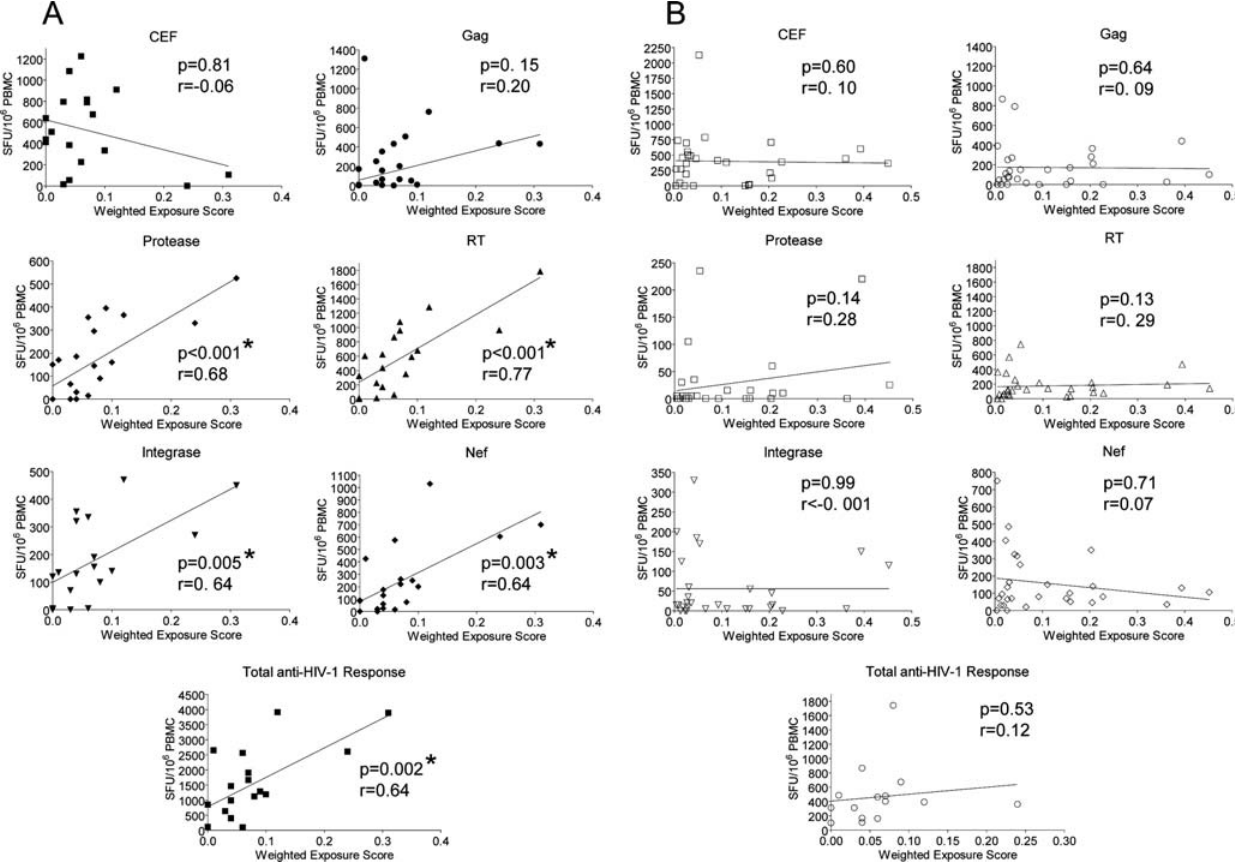
Figure 2. Correlations of exposure to a partner’s HIV-1 and T cell IFN- c response. IFN- c T cell responses from the viremic partner (VP) group (A), or non-viremic partner (NVP) group (B), were plotted against the corresponding exposure scores against the peptide pools derived from CEF, or HIV-1 proteins Gag, Protease, RT, Integrase, and Nef. The cumulative anti-HIV-1 T cell IFN- c response was also plotted. Significant correlations (denoted by *) were determined by two-tailed nonparametric spearmans correlation, spearman r (r), and linear regression analysis was plotted as a straight line.